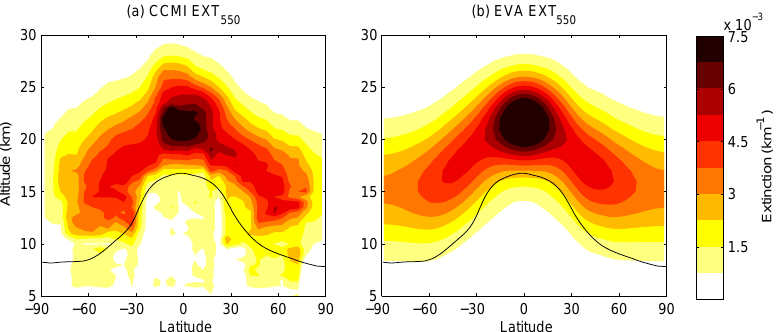
Figure 5. Aerosol extinction ( λ = 550nm) profiles for the 4-year post-Pinatubo average from (a) the CCMI database and (b) emulated by EVA.